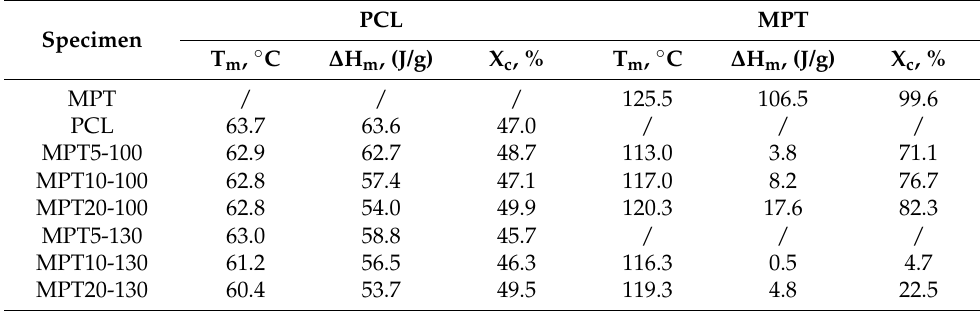
Table A2. Weight loss of PCL/MPT blends after being immersed for 35 days.